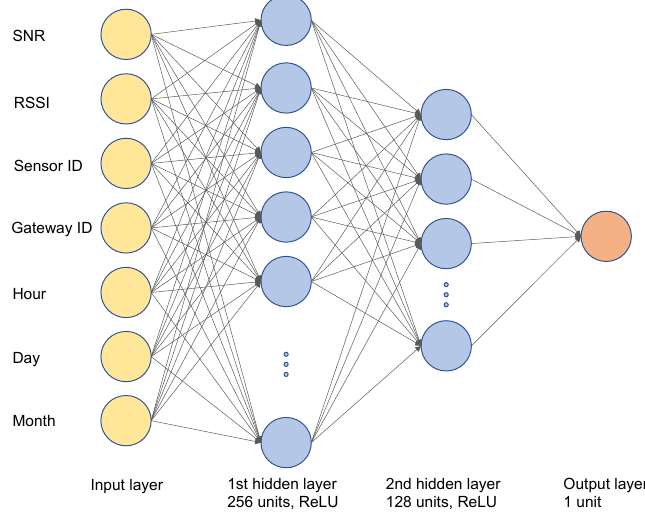
Figure 10. Architecture of Neural Network model for parking space occupancy